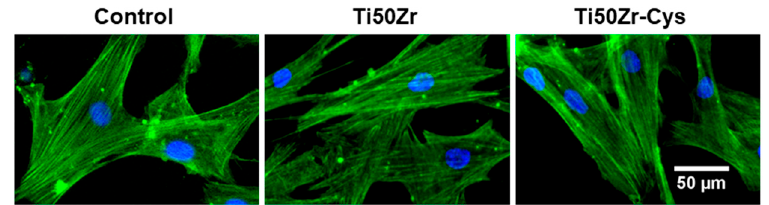
Figure 7. The actin cytoskeleton organization of HGF-1 gingival fibroblasts after 48 h of cultivation on cysteine coated Ti50Zr alloys. Scale bar: 50 µm.